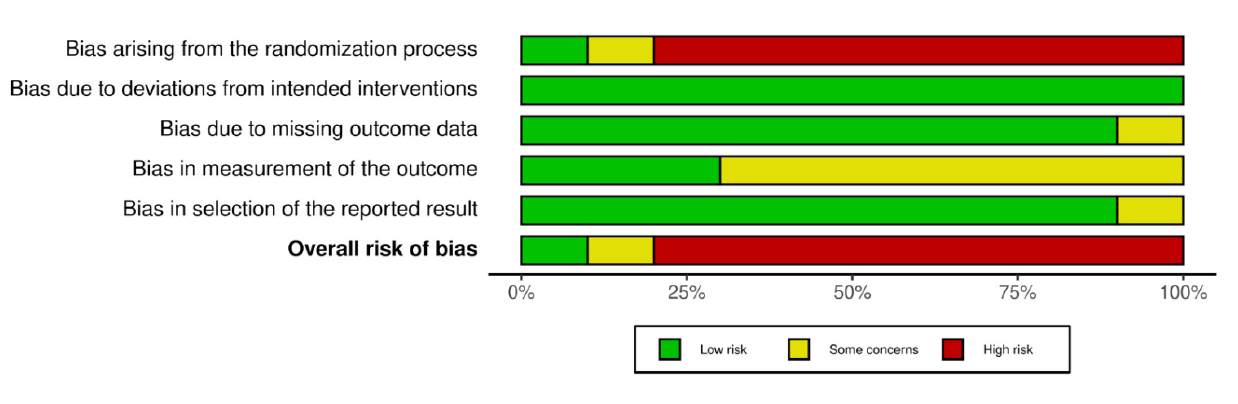
Figure 5. Horizontal bar plot showing the quantification of the risk of potential bias across studies for each risk of bias domain, expressed as percentages, assessed with the Cochrane Collaboration’s tool for assessing risk of bias (RoB-2 tool). Green, low risk of potential bias; yellow, some concerns; red, high risk of potential bias.